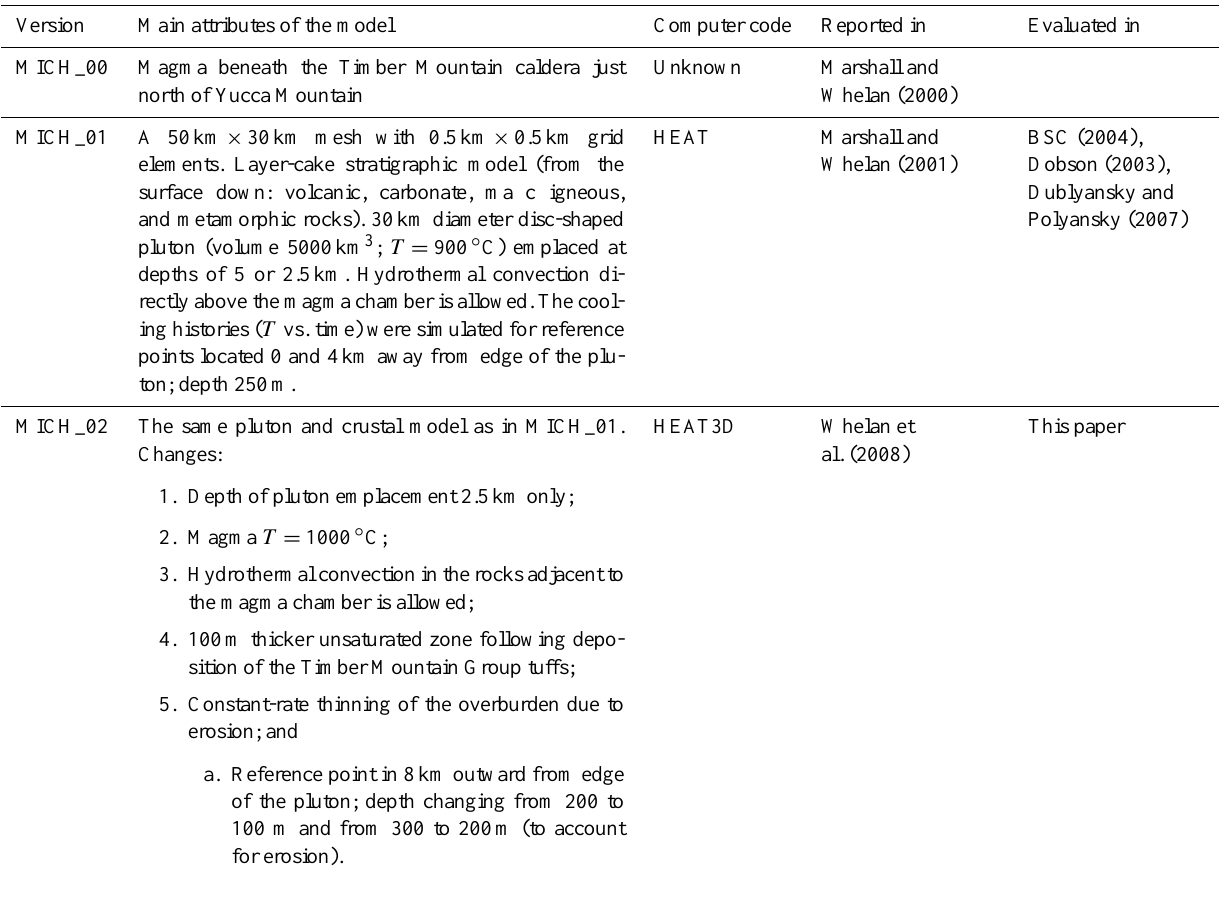
Table A1. History of the MICH model. Version Main attributes of the model Computer code Reported in Evaluated in MICH_00 Magma beneath the Timber Mountain caldera just north of Yucca Mountain